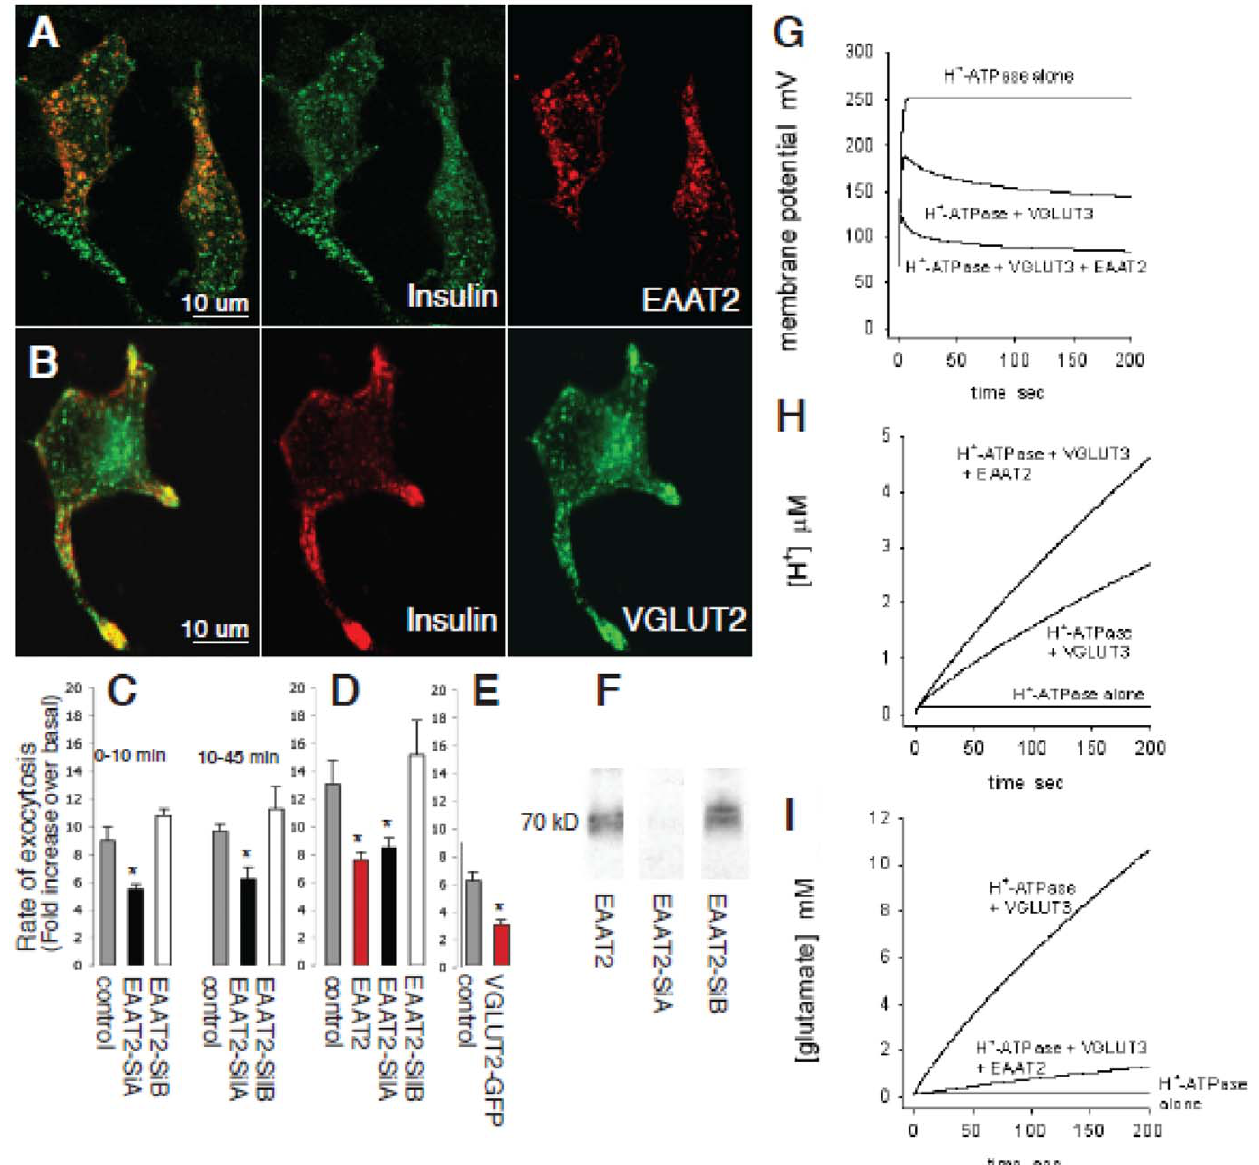
Figure 6. The effect of EAAT2 and VGLUT expression on secretory granule energetics and exocytosis. (A) INS-1E cells were transfected with EAAT2-c-Myc and the EAAT2 protein was visualized with anti-c-Myc antibodies (red). EAAT2 co-localized with insulin (green). (B) INS-1E cells were transfected with GFP-VGLUT2 and VGLUT2 visualized by the fluorescence of the GFP tag. VGLUT2 (green) co-localized with insulin (red). (C) INS- 1E cells were transiently co-transfected with a plasmid encoding hGH and with vectors directing the sequence of two different short interfering RNAs for EAAT2 (EAAT2 SiA and EAAT2 SiB) or with empty pSUPER vector (control). The cells were incubated under basal and stimulatory conditions (see methods) for 10 and 45 min. hGH secretion was measured by ELISA as the fold increase over basal conditions. The EAAT2 SiA values were significantly different from control and EAAT2 SiB values (*, unpaired Student’s t-test, p , 0.05, n=3). (D) In another set of experiments INS-1E cells were cotransfected with hGH and the pSUPER control vector alone (control) or with EAAT2, EAAT2 SiA or EAAT2 SiB, and incubated for 45 min as in C. EAAT2 and EAAT2 SiA values were significantly different from control and EAAT2 SiB values (*, unpaired Student’s t-test, p , 0.05, n=3). (E) INS-1E cells were transiently co-transfected with hGH and VGLUT2-GFP or GFP (control). The VGLUT2 value was significantly different from the control value (*, unpaired Student’s t-test, p , 0.05, n=3). (F) INS-1E cells were cotransfected with c-Myc-tagged EAAT2 and the two siRNAs targeting different sequences of EAAT2 (EAAT2 SiA and EAAT2 SiB). The Western blots show that the EAAT2 SiA almost completely blocked the expression of EAAT2, whereas EAAT2 SiB had no effect. (G–I) Simulations of the effect of VGLUT3 and EAAT2 on granule energetics. Granule cell membrane potential (G), [H + ] (H) and [glutamate] (I) are shown for a granule membrane containing the H + -ATPase alone, ATPase and VGLUT3, or ATPase, VGLUT3 and EAAT2 (see supplementary text S1). doi:10.1371/journal.pone.0022960.g006 insulin secretion is modulated by the two types of glutamate the secretory granules. Interestingly, the glutamate concentration transporter present in the secretory granules, which act in series to within a - and b - cells seems to be regulated by the flux of the optimise the intragranular pH and the membrane potential across glutamate precursor glutamine between these cells [31].